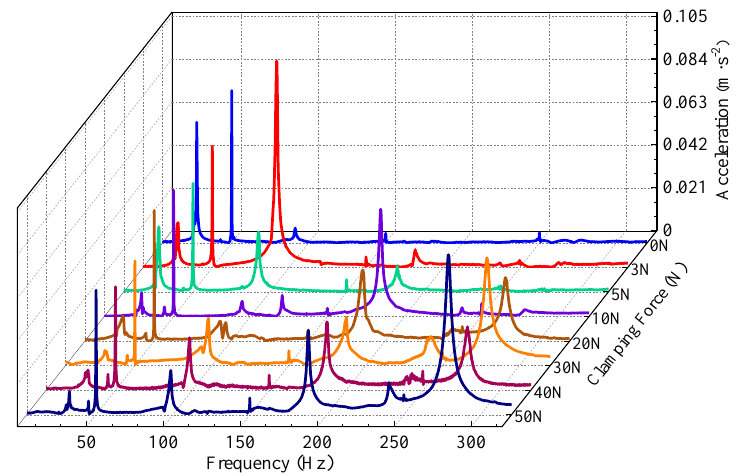
Figure 7. Natural frequencies of the double-span tube under different clamping forces.